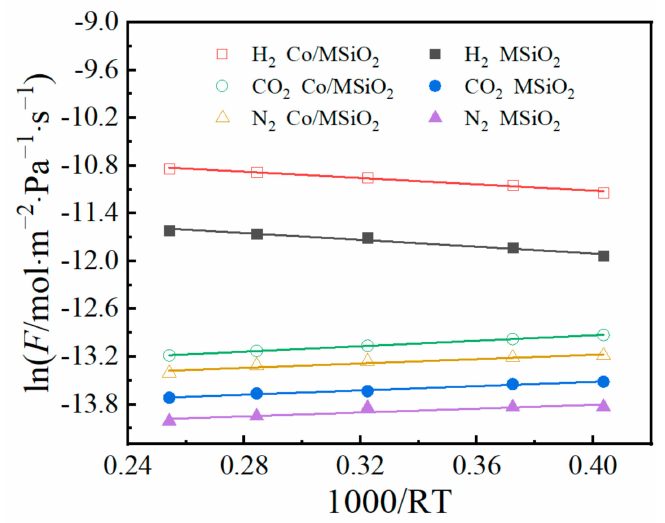
Figure 10. Arrhenius plots of gases’ (H 2 , CO 2 , and N 2 ) permeances in supported MSiO 2 membrane and supported Co/MSiO 2 membrane with n Co = 0.08 at 0.2